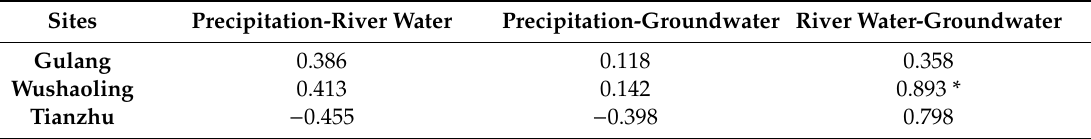
Figure 6. δ 18 O and δ 2 H in river water and groundwater where ( a , b ) are the δ 18 O and δ 2 H measurements, respectively, in river water and groundwater at Gulang; ( c , d ) are the measurements for Wushaoling; and ( e , f ) are the measurements for Tianzhu. Table 7. The correlation relationships between precipitation, river water, and groundwater.